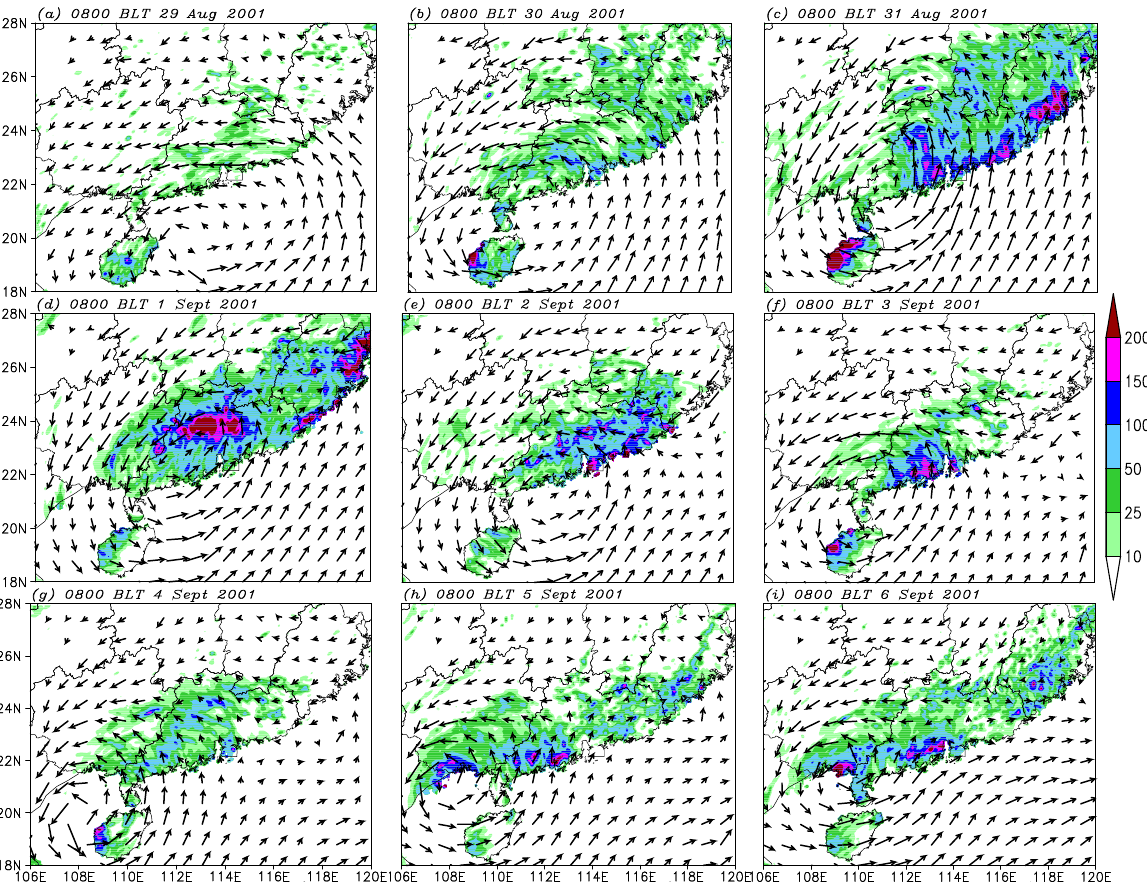
Figure 7. Simulated 900-hPa wind and 24-h rainfall by Exp CTL at 0800 BLT on